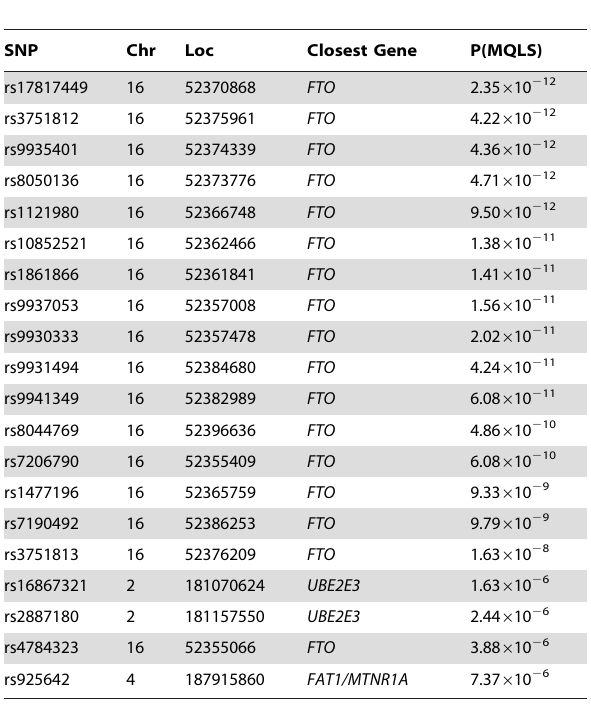
Table 4. Most significantly associated SNPs in the combined case/control and family cohort.